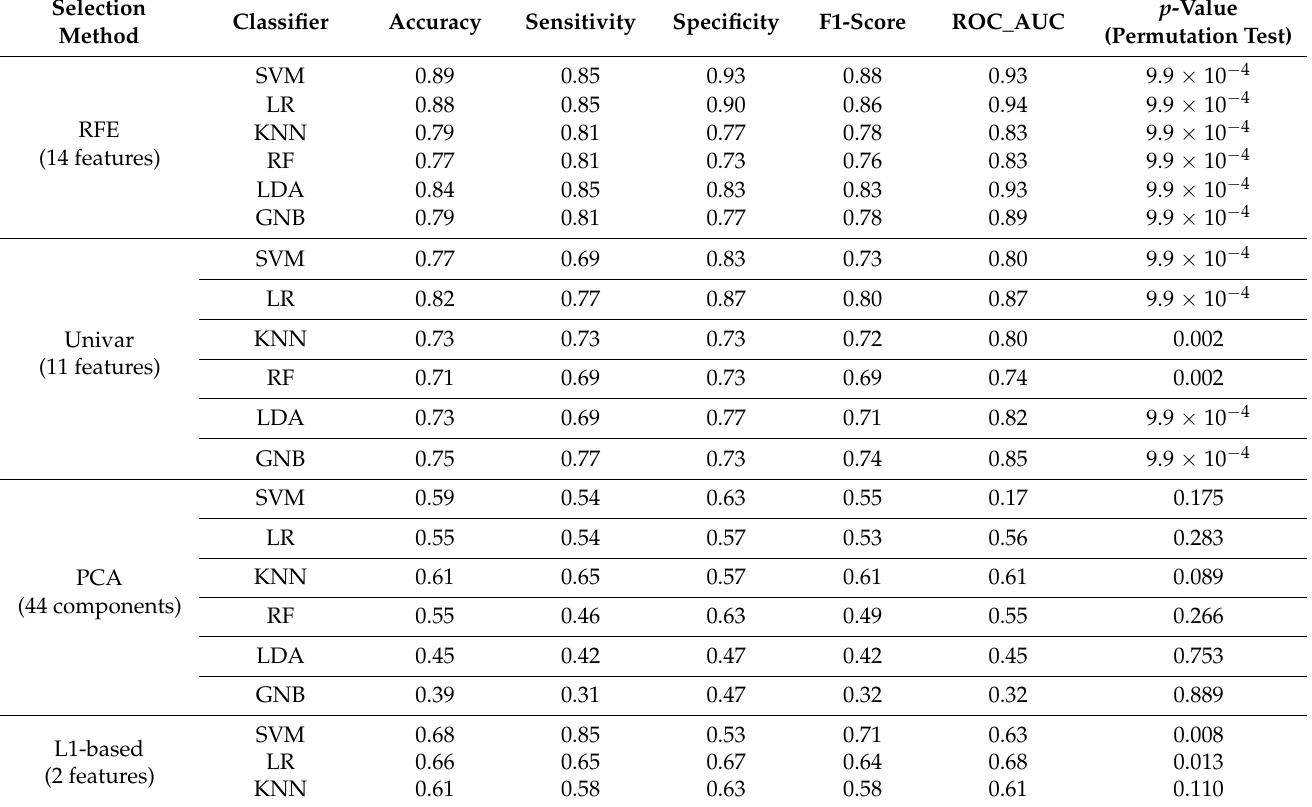
Table 2. Comparing performance among different combinations of four feature selection methods and six classifiers in resting-state functional connectivity